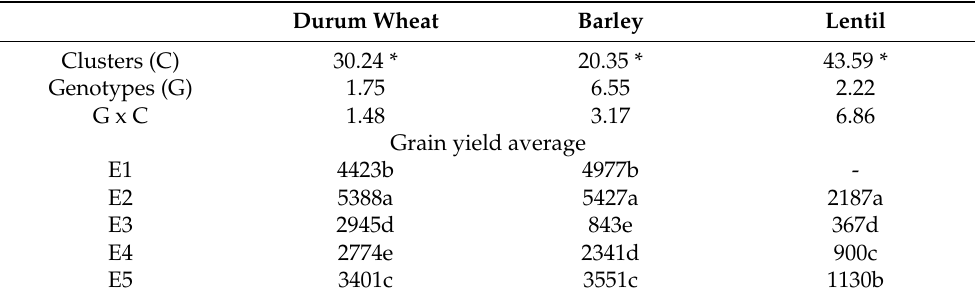
Table 1. Analysis of variance (expressed as percentage) and mean values of grain yield (kg ha − 1 ) across identified clusters for durum wheat, barley, and